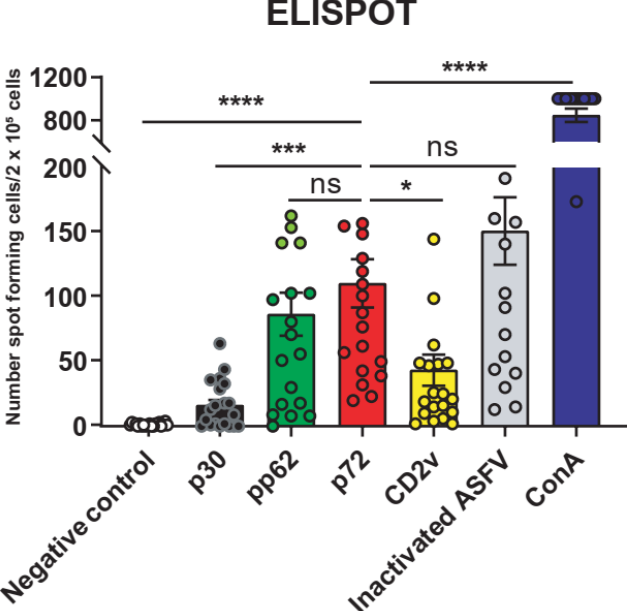
Figure 1. Peripheral blood mononuclear cells (PBMCs) from surviving ASFV-infected pigs responded to ASFV protein expression. The ELISPOT assay verified the ability of the 4 ASFV proteins and the inactivated ASFV to stimulate the production of IFN- γ on PBMCs of the surviving pigs (n = 20). A total of 0.5 µ g/mL concanavalin A (Con A) was used as a positive stimulation. The data are shown as the mean ± SEM. p -values were determined by one-way ANOVA (ns, p > 0.05; * p < 0.05; *** p < 0.001; and **** p <